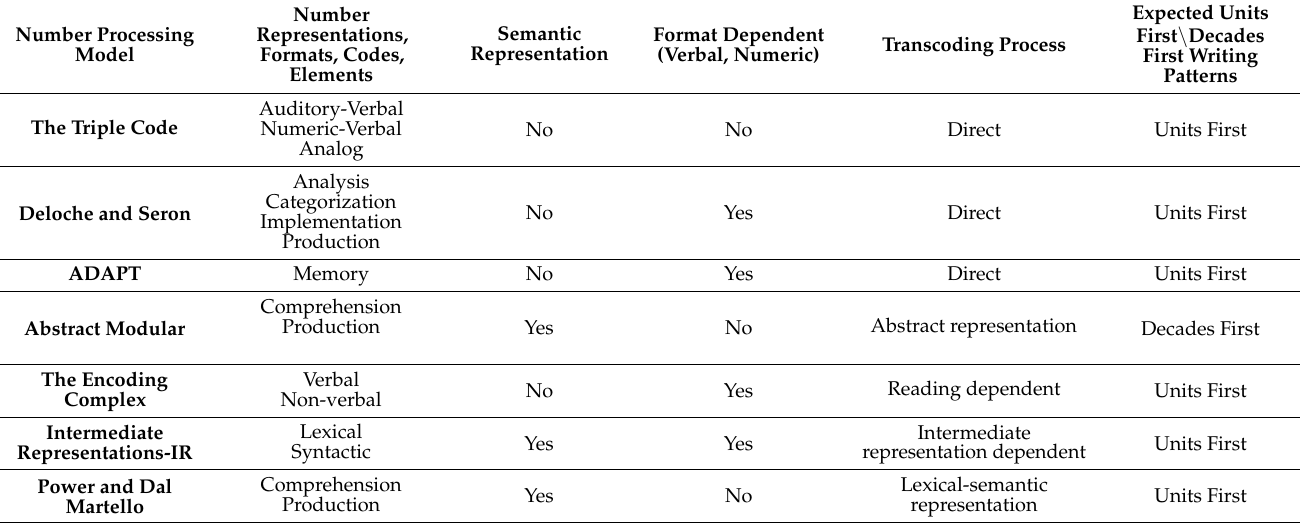
Table 1. Summary of number processing models and their predicted units \ decades first writing patterns in two-digit numbers transcoding to